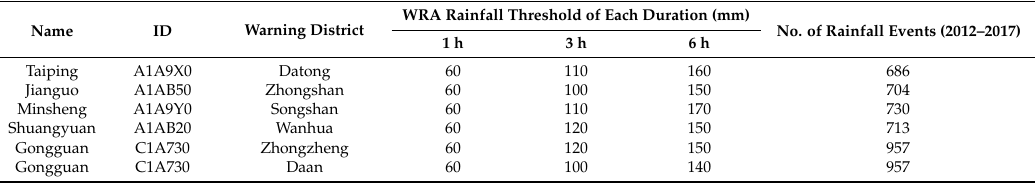
Figure 2. Flood warning districts and rain gauge locations in central Taipei. Five rain gauges are used to issue flood warnings in central Taipei and the location, start time and number of rainfall events are shown in Figure 2 and Table 1. The number of rainfall events ranges from 686 to 957 collected from 2012 to 2017. Each rain gauge can trigger an alert to the inundation area. Table 1. The rain gauges in central Taipei and WRTs of the five rain gauges for flood warnings to six districts within central